Question: Judging by this figure, is the value going up or going down?
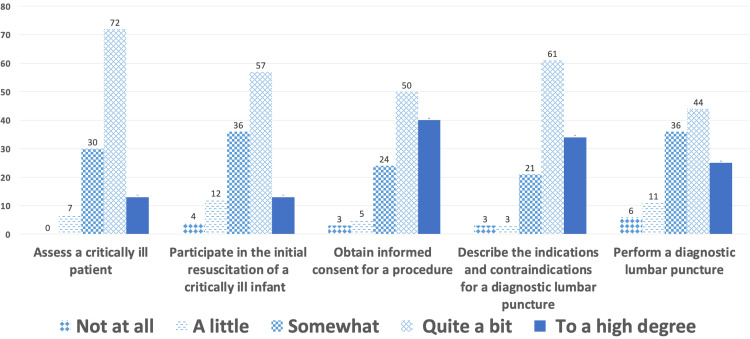
Answer: increasing